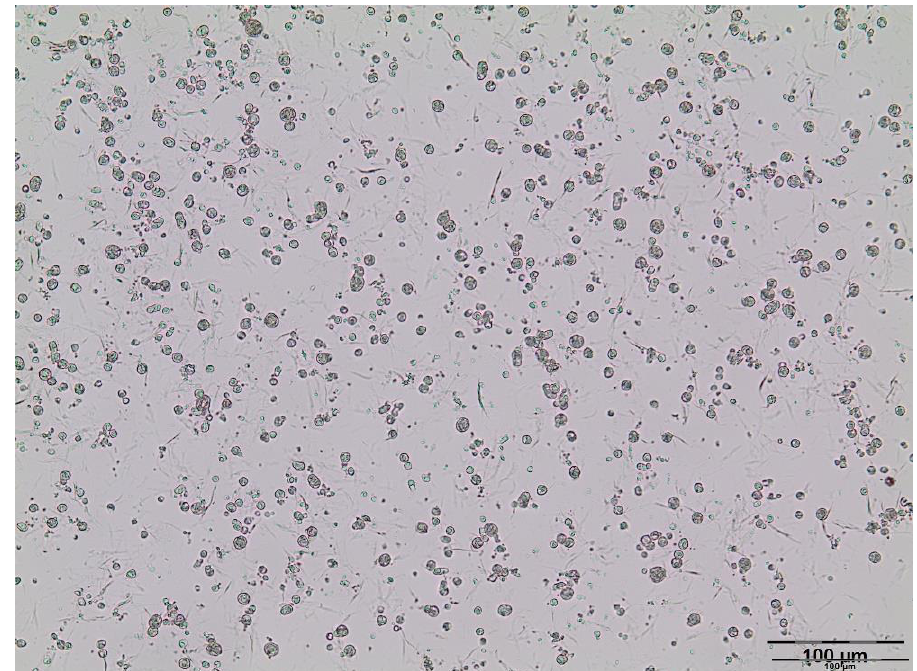
Figure 2. Photomicrograph of double (W/O/W) emulsion D.